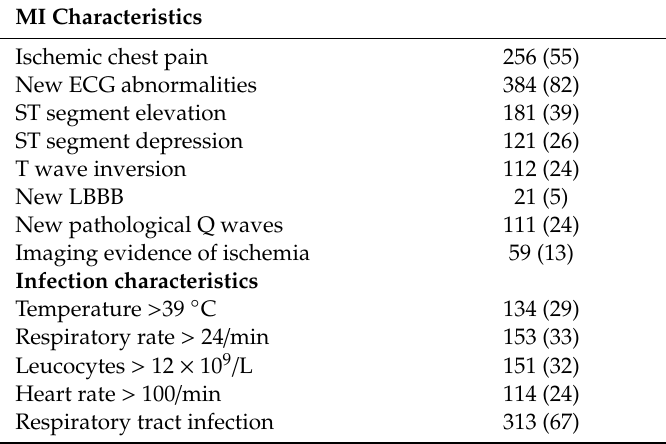
Table 2. Characteristics of post-infectious myocardial infarction at admission ( n